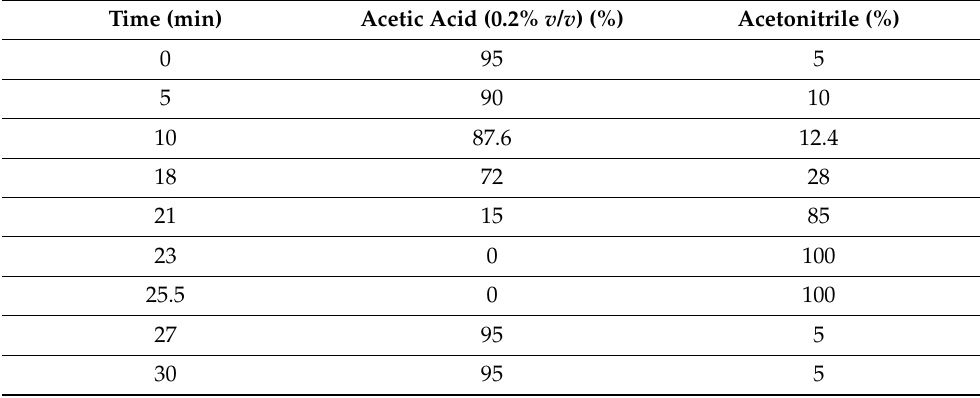
Table 1. Chromatographic conditions for phenolic compounds identification by